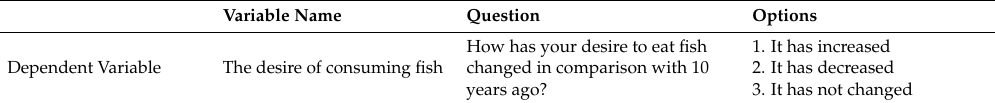
Table 1. Summary of the survey questionnaire for multiple logistic